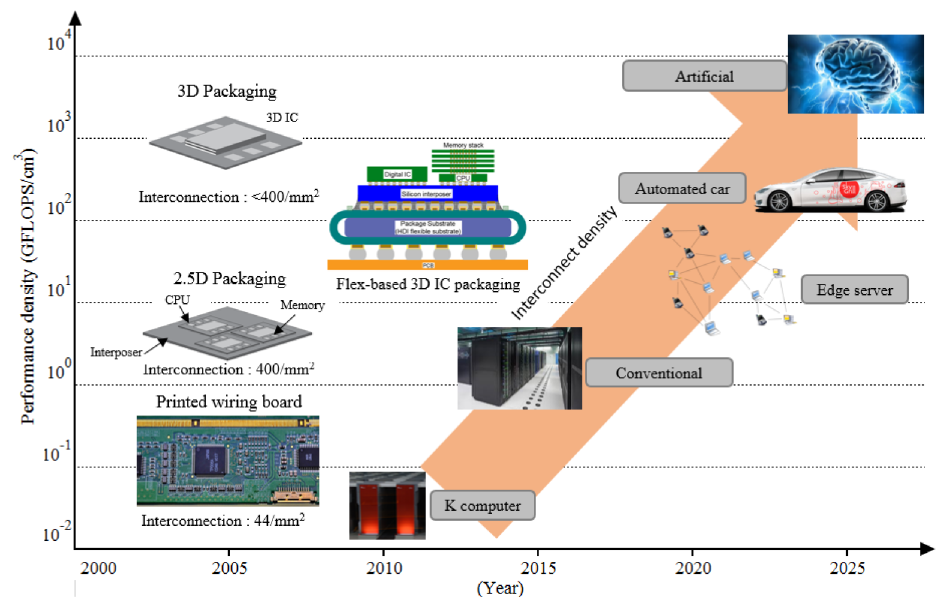
Figure 4. Device packaging technology for servers (Aoki,